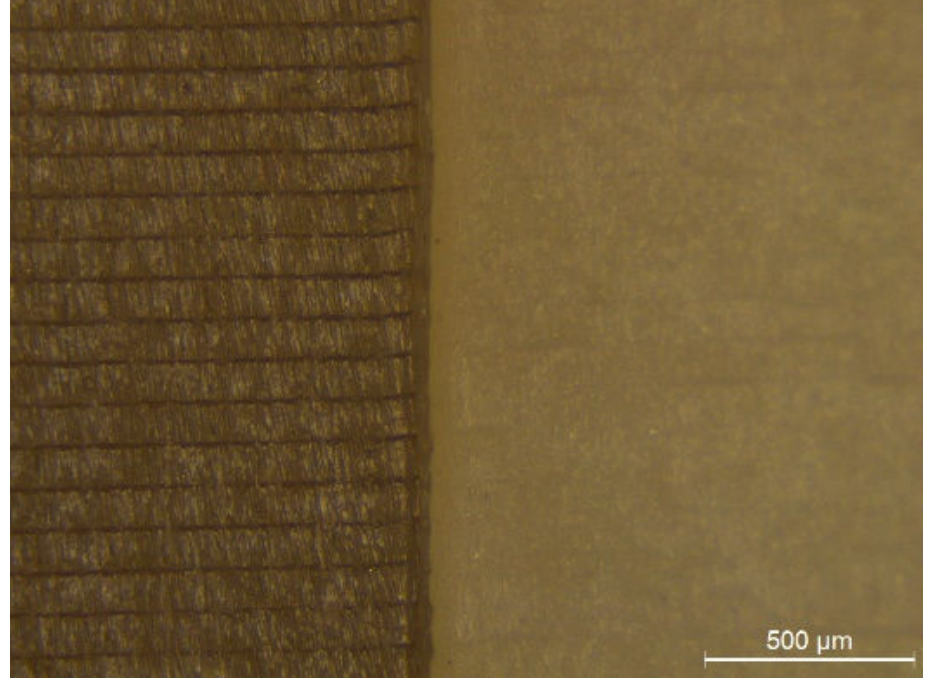
Figure 7. Stereomicroscopy image of two 3D printed specimens using raw HT resin ( left ) and hybrid ceramic HT resin ( right ). The printing layers of raw HT resin are evident along the printing axis while they are concealed in the hybrid ceramic .